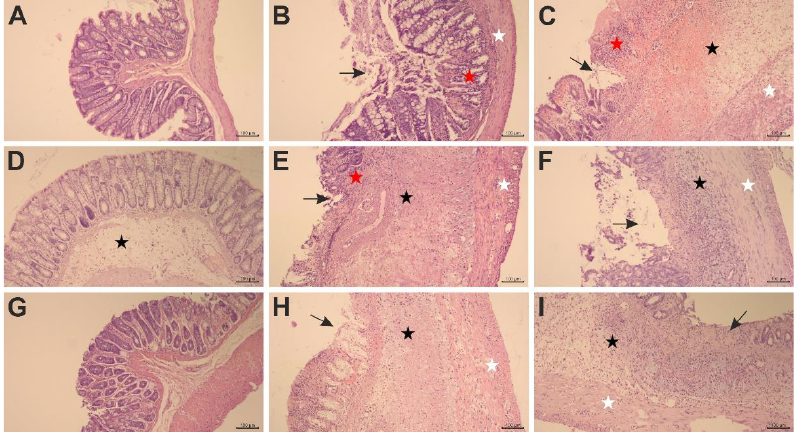
Figure 2. The photomicrographs of the colon tissues after hematoxylin–eosin staining revealed that compound 7b (10 and 20 mg/kg) and compound 13b (20 mg/kg) diminished TNBS-induced histological alterations; arrow in black, ulceration of the mucosa; star in red, inflammatory infiltrates within the lamina propria of the mucosa; star in black, edema within the submucosa; star in white, inflammatory infiltrates within the muscularis mucosa. Control group ( A ); group receiving only TNBS ( B , C ); group receiving 10 mg/kg compound 7b and TNBS ( D ); group receiving 20 mg/kg compound 7b and TNBS ( G ); group receiving 10 mg/kg compound 10b and TNBS ( E ); group receiving 20 mg/kg compound 10b and TNBS ( H ); group receiving 10 mg/kg compound 13b and TNBS ( F ); group receiving 20 mg/kg compound 13b and TNBS ( I ); magnification 100 ×